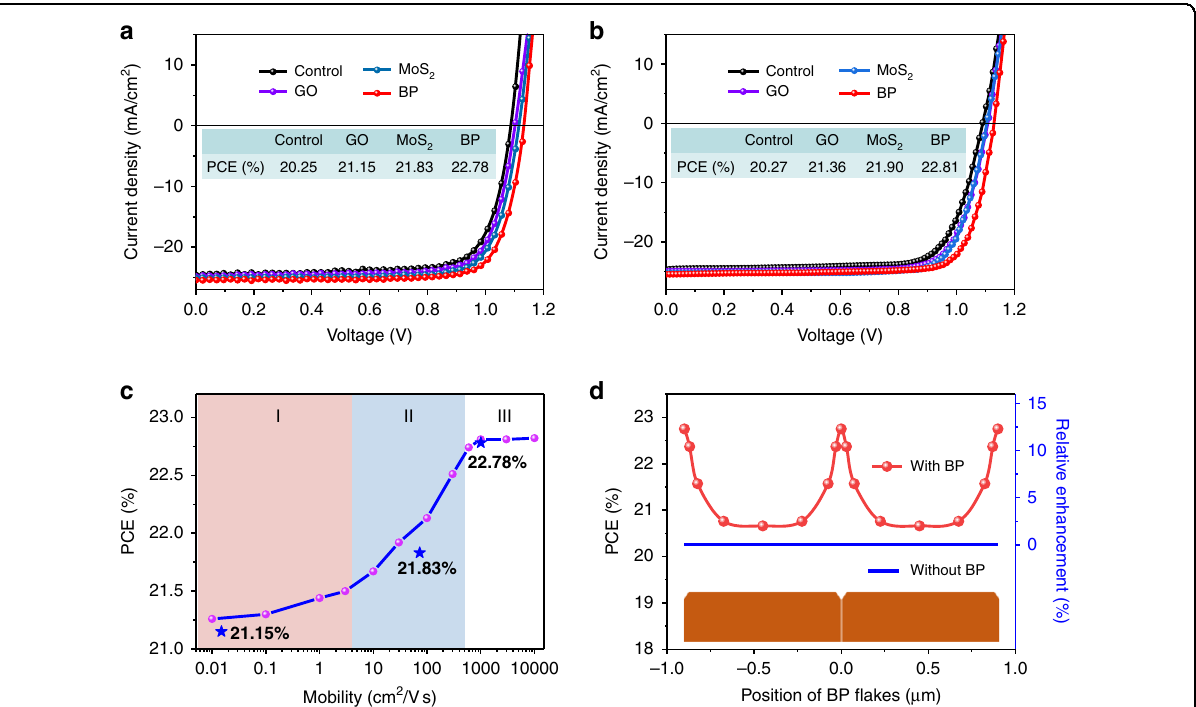
Fig. 6 Photovoltaic performances of the mixed PSCs. a , b Experimental ( a ) and simulated ( b ) J – V curves of the mixed PSCs modi fi ed with different 2D fl akes on perovskite GBs. c Simulated device ef fi ciencies of the mixed PSCs with varying mobilities of 2D fl akes. The three regions (I, II and III) correspond to the carrier mobilities of the three different 2D fl akes (GO, MoS 2 and BP), and the star symbols represent the experimental ef fi ciencies of the PSCs modi fi ed with the three different 2D fl akes in 6a. d Simulated device PCEs and ef fi ciency enhancement for BP fl akes located at different positions on the perovskite grains. The length of a single BP fl ake is ~42 nm in all